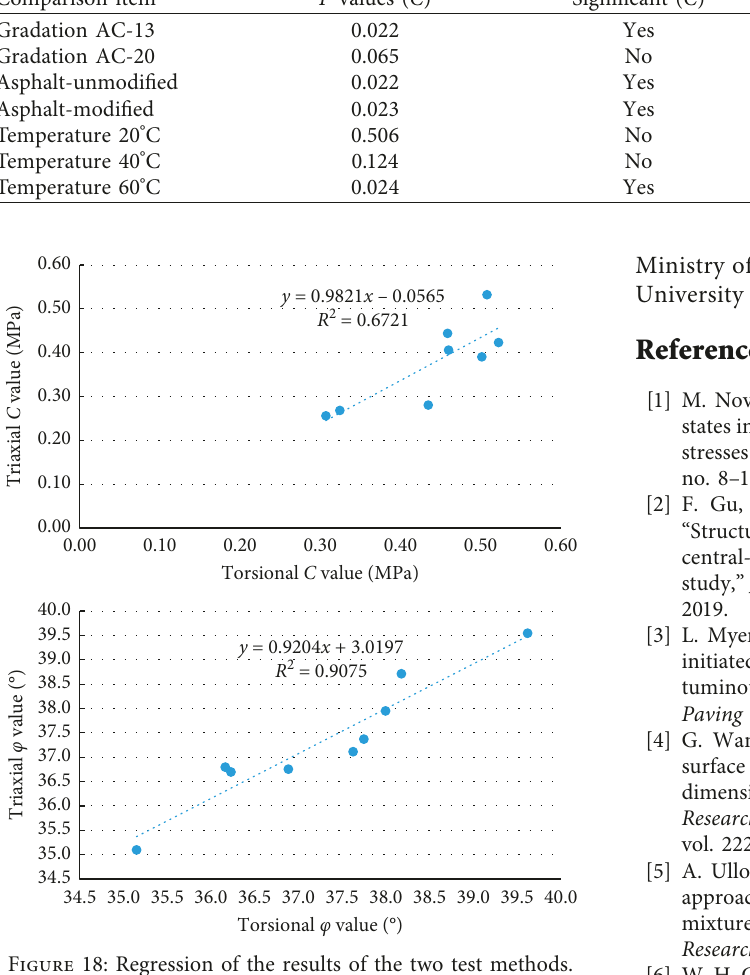
Figure 18: Regression of the results of the two test